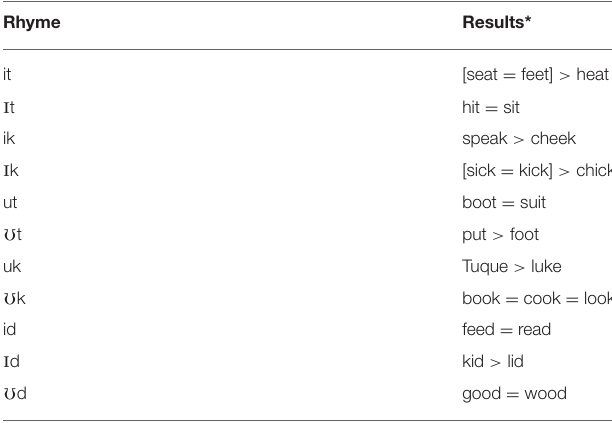
TABLE 8 | Statistical comparisons of %-correct ID for words with identical rhymes. Rhyme